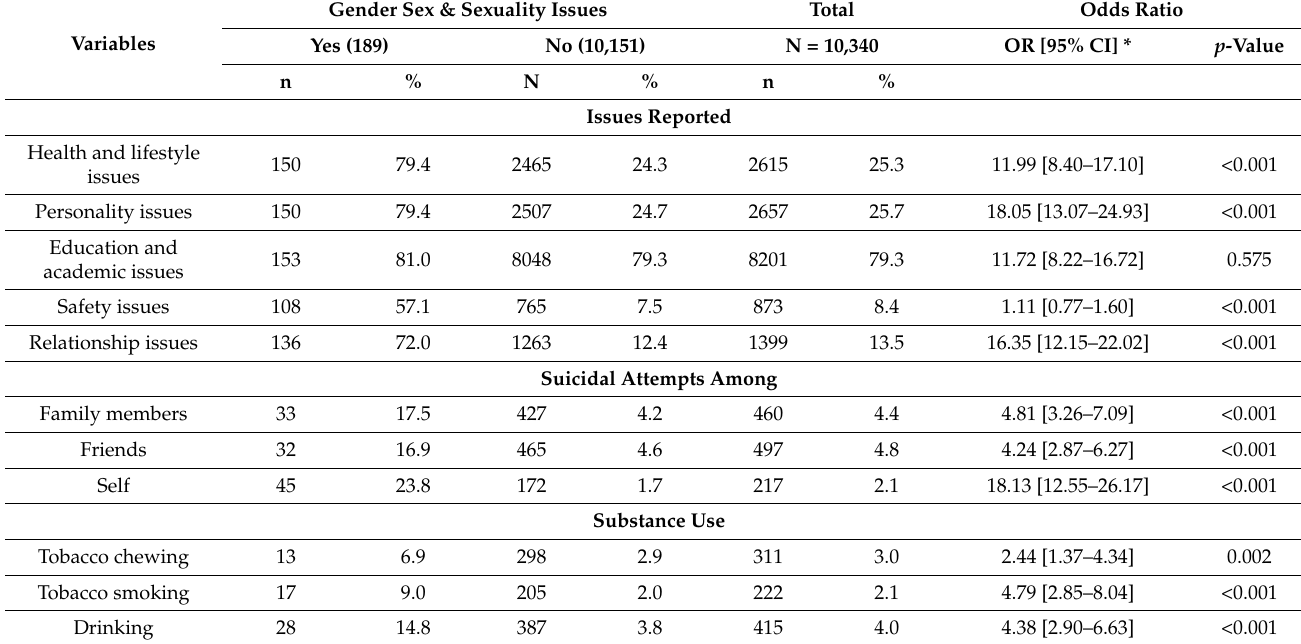
Table 2. Issues reported, suicidal attempts, substance use and gender, sex and sexuality issues among beneficiaries attending youth mental health promotion clinics during 2017–2020 in Karnataka (N = 10,340).